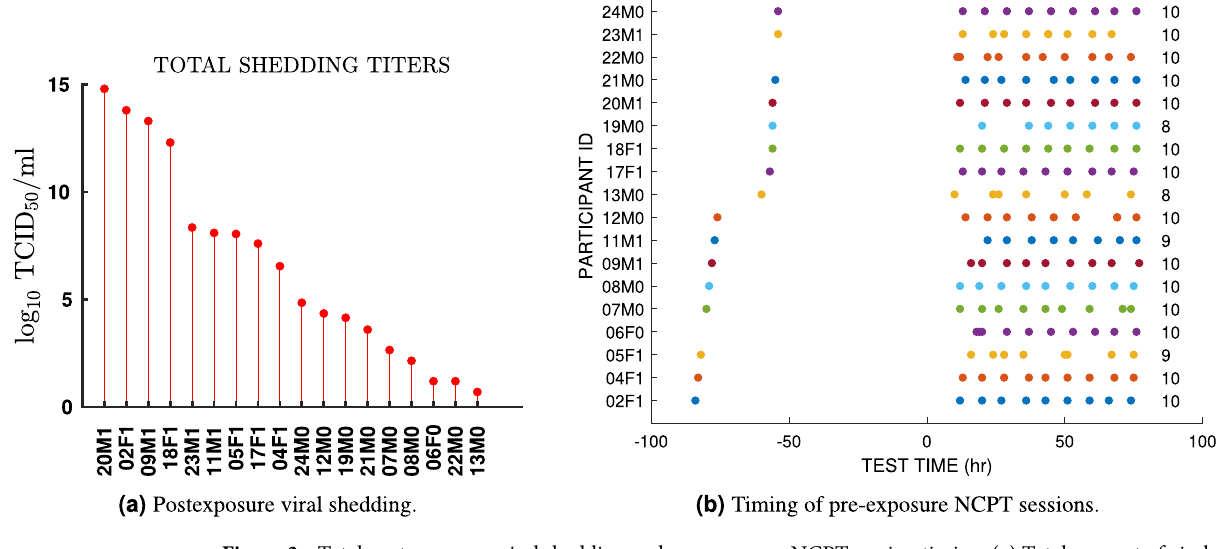
Figure 3. Total post-exposure viral shedding and pre-exposure NCPT session timing. ( a ) Total amount of viral shedding accumulated from the time of exposure to the end of the study, indexed over participant ID’s. The participant ID encodes the participant index (numeric first two characters from 1 to 20) the participant gender (M or F second character) and whether the participants’ shedding is below or above (0 or 1) the population median of total viral shedding (5.7 titers). ( b ) Timing of the pre-exposure NCPT testing sessions for each of the 18 challenge study participants during the baseline part of the challenge study (0–80 h), which precedes exposure to the HRV pathogen. Appearing on the far left of the figure are the participants’ initial screening sessions which, for all but two participants, occurred several days before the start of the study. At far right of the figure is shown the total number of sessions, varying between 8 and 10, for each